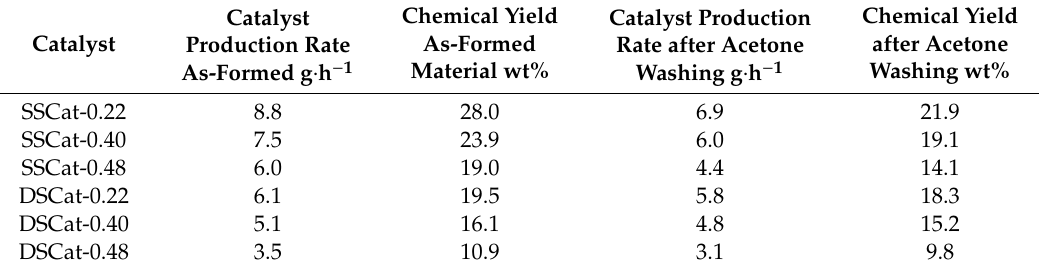
Table 1. Rate production and chemical yield for the SSCat and DSCat catalysts syntheses with R =